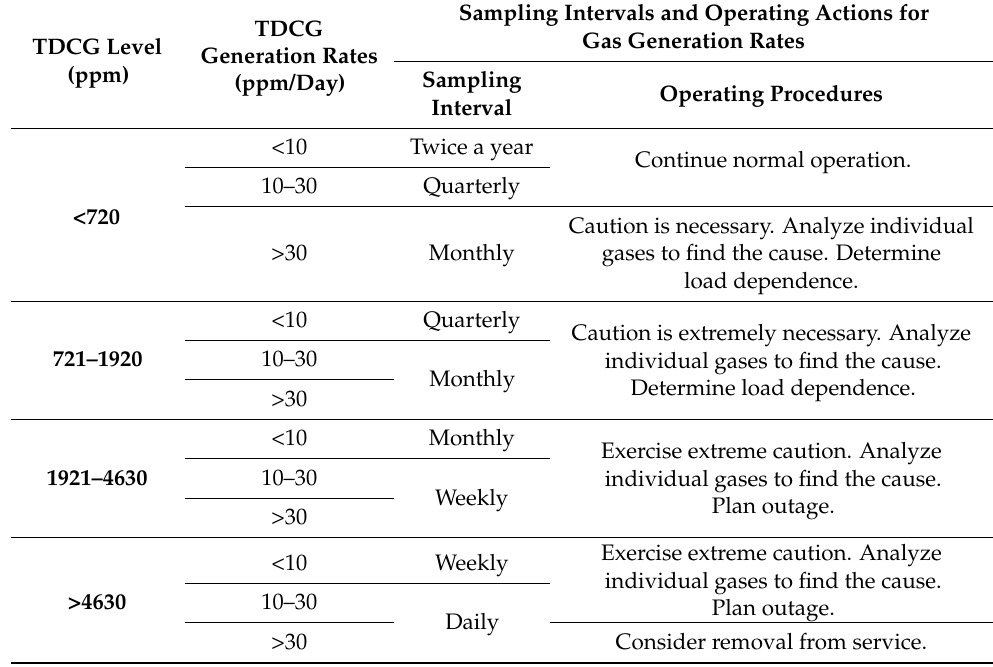
Table 7. TDCG Method—Limits and operating procedures (adapted from